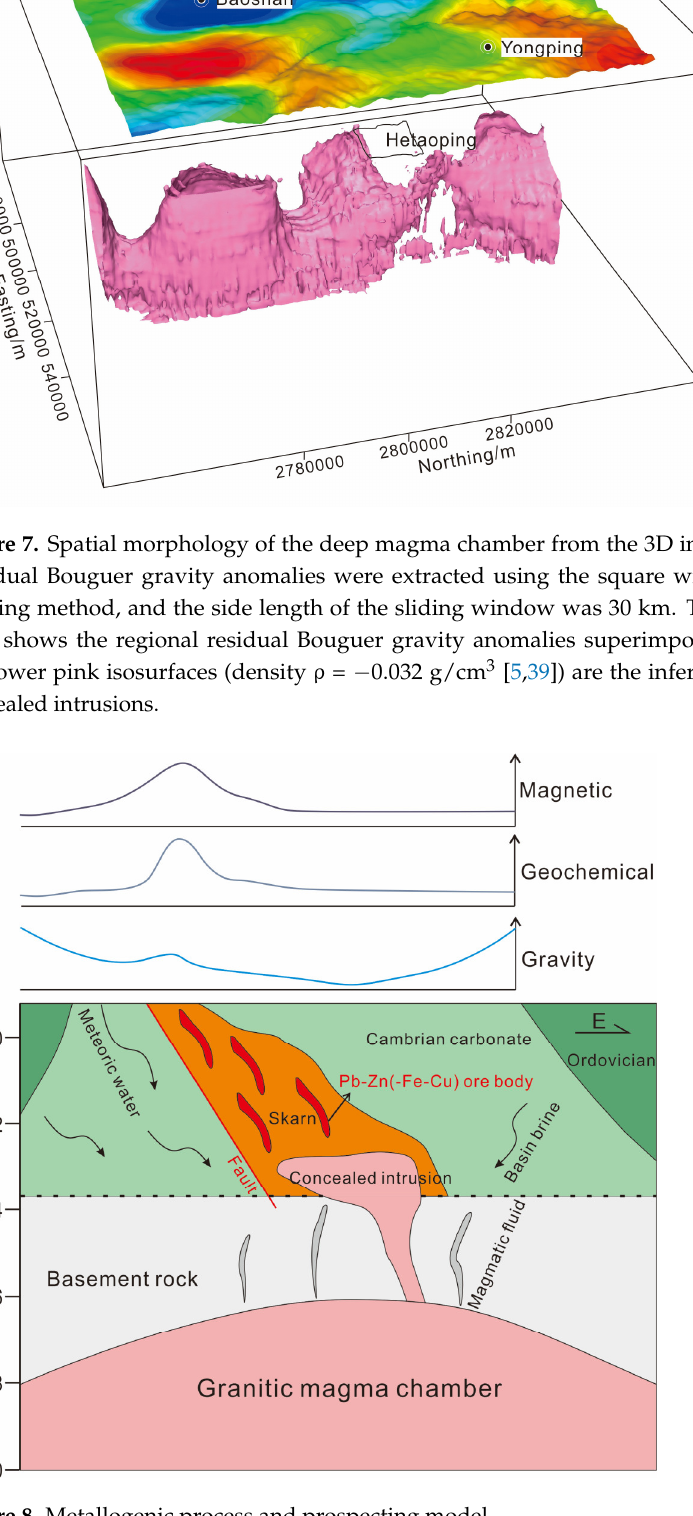
Figure 8. Metallogenic process and prospecting